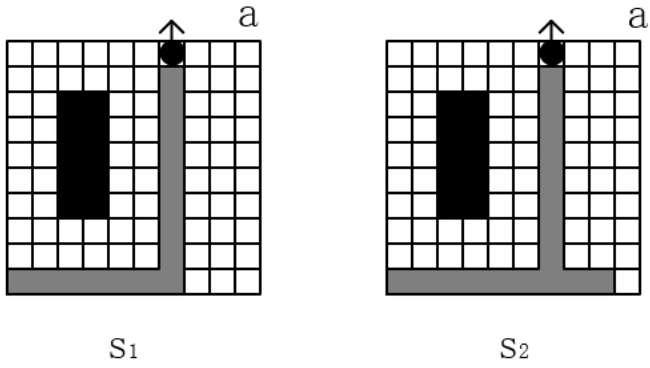
Figure 10. Dangerous actions in different